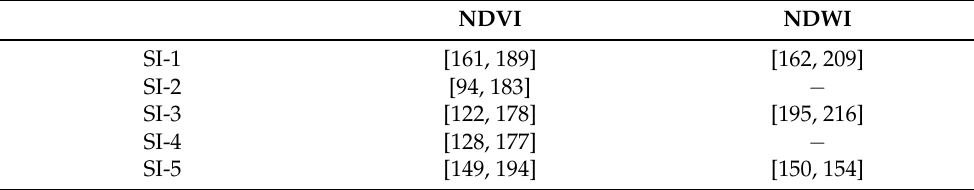
Figure 5. Five subsets from dataset of D1 and D2. Table 1. The range [ T trough , T peak ] of spectral indice, including NDVI and NDWI, on five subset